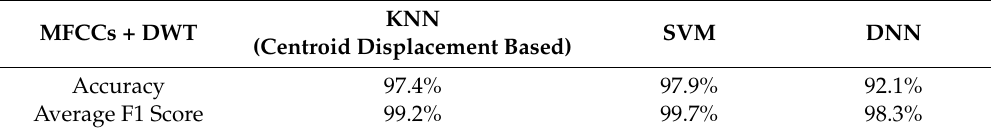
Table 5. Result based on MFCCs and DWT Features.